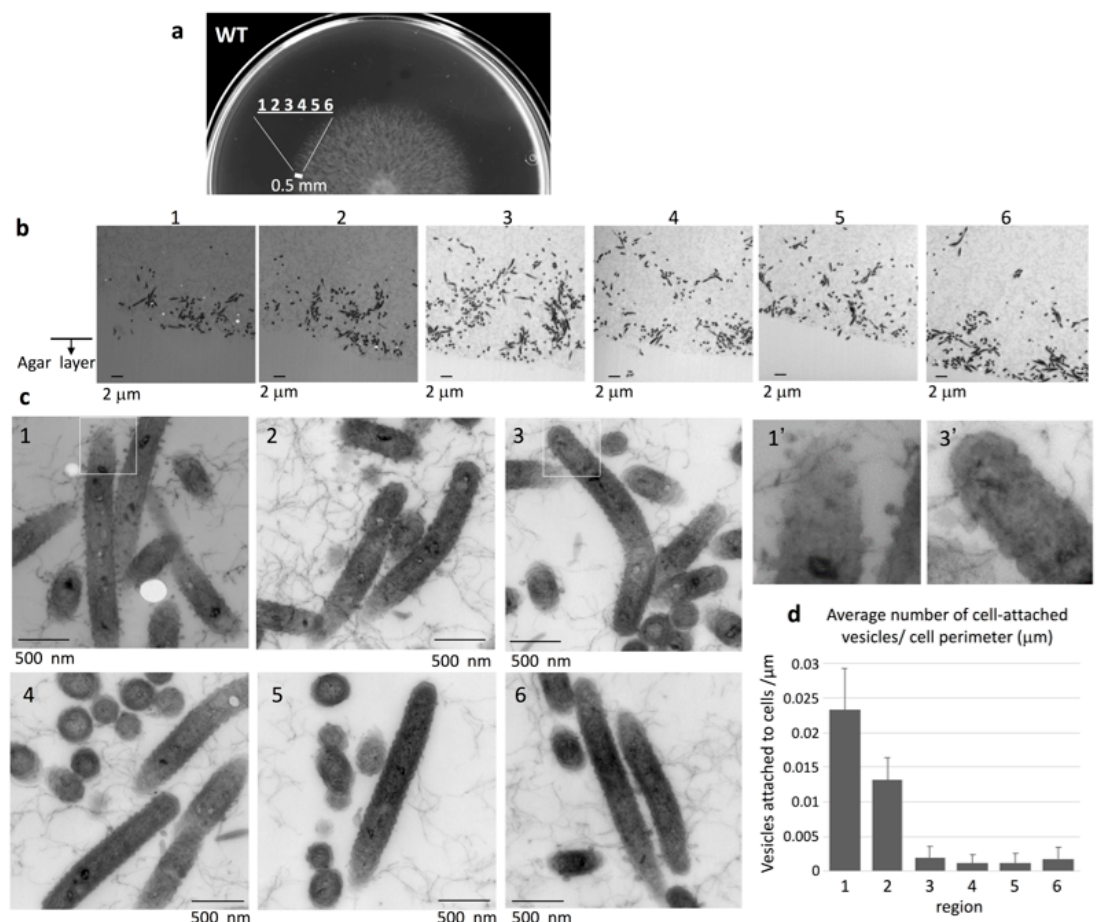
Figure 3. TEM of the extending edge of a WT colony on 1% A-PY2. ( a ) Overview of the sampled region of the spreading colony. ( b ) Images from regions 1–6 are indicated in Figure 3a. The bacterial layer on the agar surface is shown, with the cross-section along the axis of spreading and perpendicular to the agar surface (Figure S1b). The vacant area at the bottom of each image is the agar layer. ( c ) (1–6) Higher magnification images of the corresponding panels in Figure 3b. (1 (cid:48) ) and (3 (cid:48) ) are 3 × enlarged images of the squares in (1) and (3), respectively. ( d ) The density of cell-attached vesicles per perimeter of cells (vesicles/mm) was measured. The areas around 33 cells were analyzed for each region. More vesicles were attached to the cells in region 1 and 2 than those in region 3, 4, 5 and 6 (Figure 3b,c). Symbols on the graph represent the average density, and the error bars correspond to the